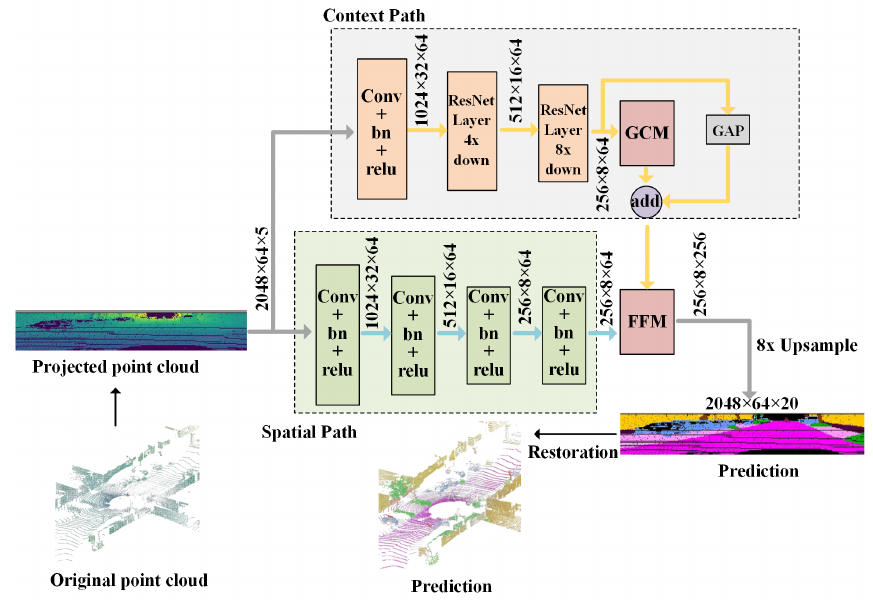
Figure 1. Architecture of the proposed CNN for point-cloud semantic